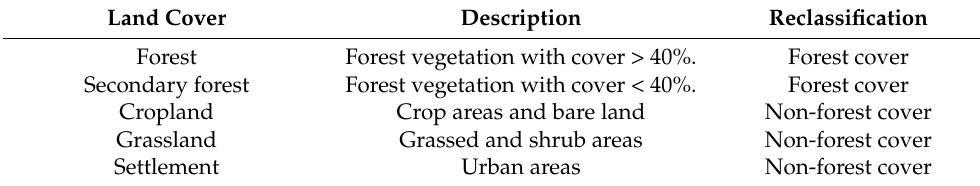
Table 1. Land cover types and reclassification to forest/non-forest cover. Land Cover Description Reclassification Forest Forest vegetation with cover > 40%. Forest cover Secondary forest Forest vegetation with cover < 40%. Forest cover Cropland Crop areas and bare land Non-forest cover Grassland Grassed and shrub areas Non-forest cover Settlement Urban areas Non-forest